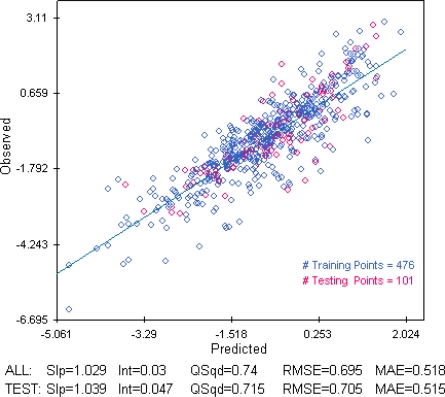
Example of an “in-house” developed QSAR to predict toxicity (LC50).